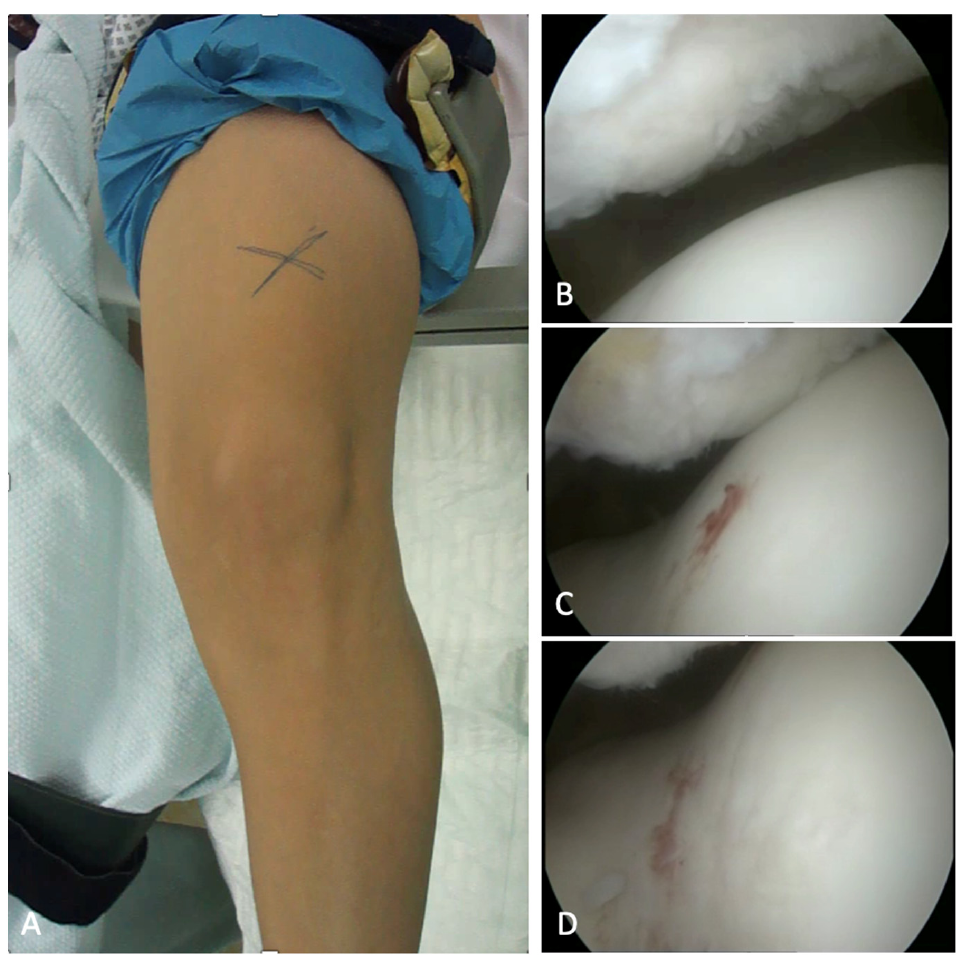
Figure 3. Patient set-up during surgery. The knees were placed in an electric leg holder with an inactive, but ready-to-use tourniquet ( A ). A diagnostic arthroscopy was performed at the beginning of surgery, in order to evaluate patellar tracking during passive range of motion, as well as the patellofemoral cartilage ( B – D ).